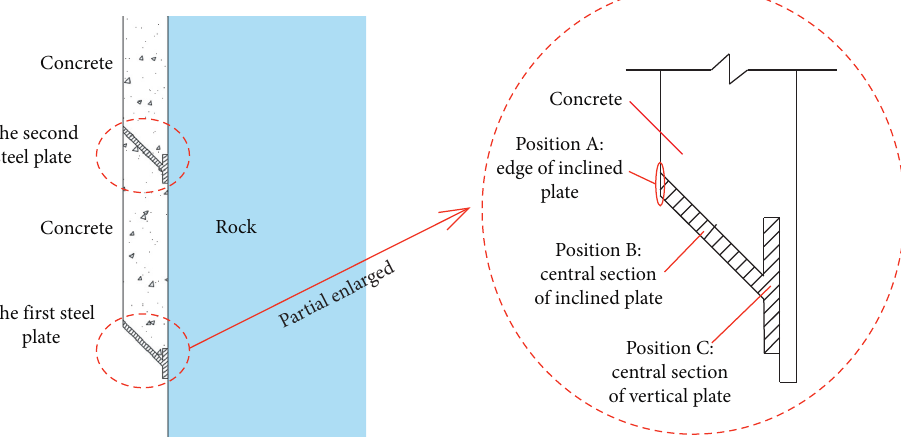
Figure 3: Partial enlargement of the joint plate.